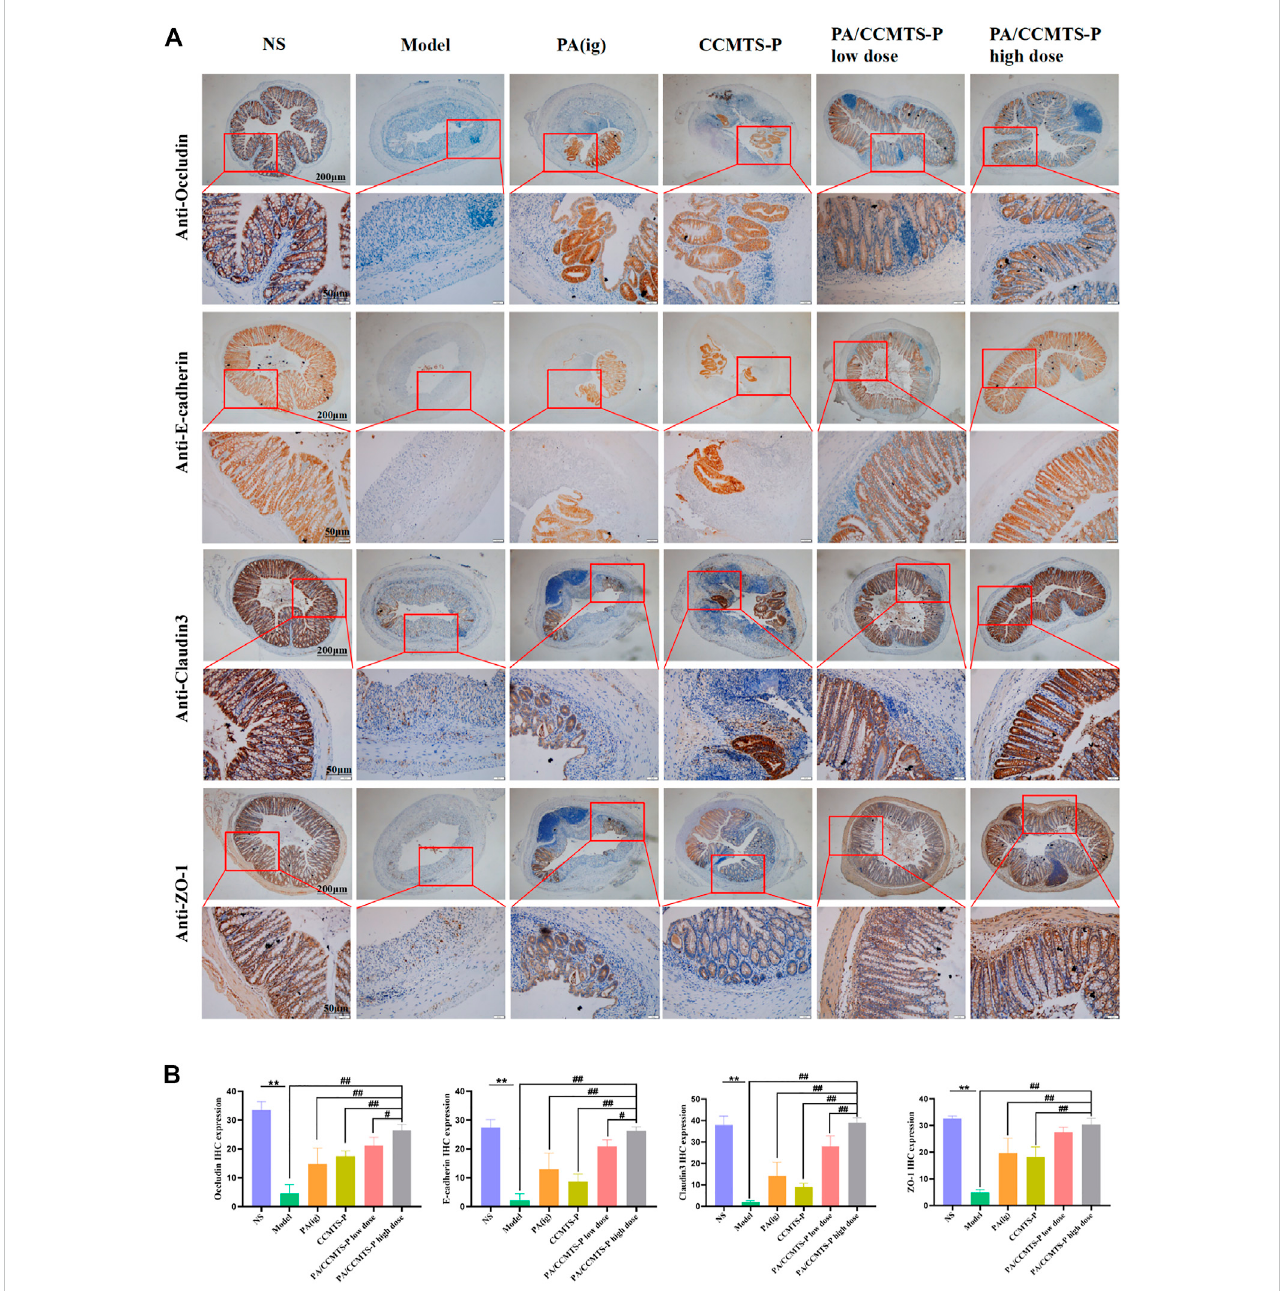
FIGURE 5 The protective effect of PA/CCMTS-P on intestinal mucosal barrier in DSS-induced UC model. (A) IHC evaluation of the four representative TJ and AJ proteins Occludin, E-cadherin, Claudin-3 and ZO-1. Scale bars, 200 and 50 μ m. (B) Histochemicalpositivearea statistics for Occludin, E-cadherin, Claudin-3 and ZO-1 ( n = 3). Data are shown as means ± SD ( n = 3),** p < 0.01; # p < 0.05, ## p <